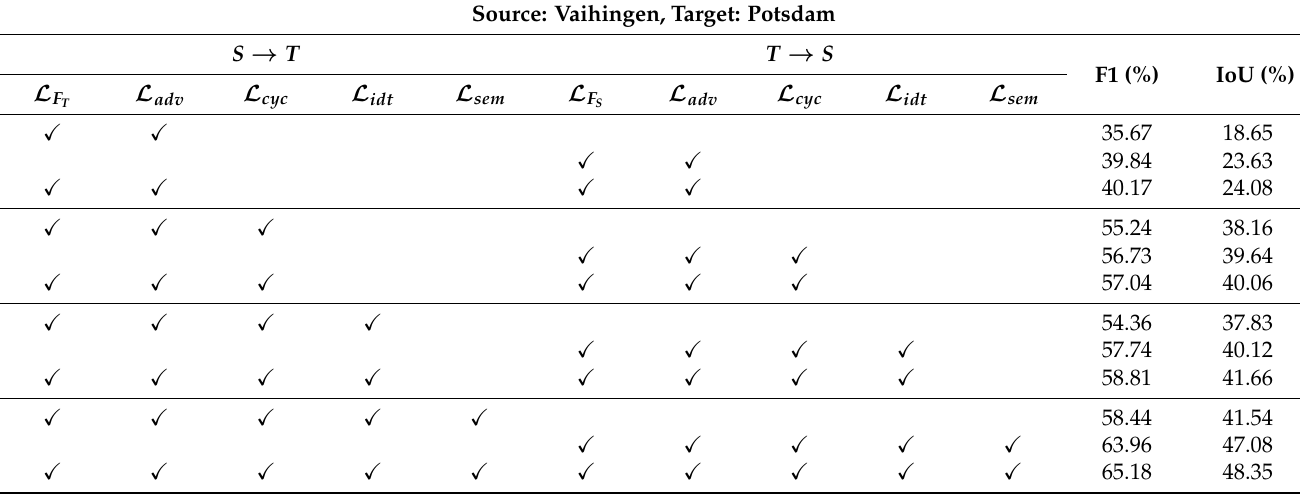
Table 6. Evaluation results of each component on ISPRS